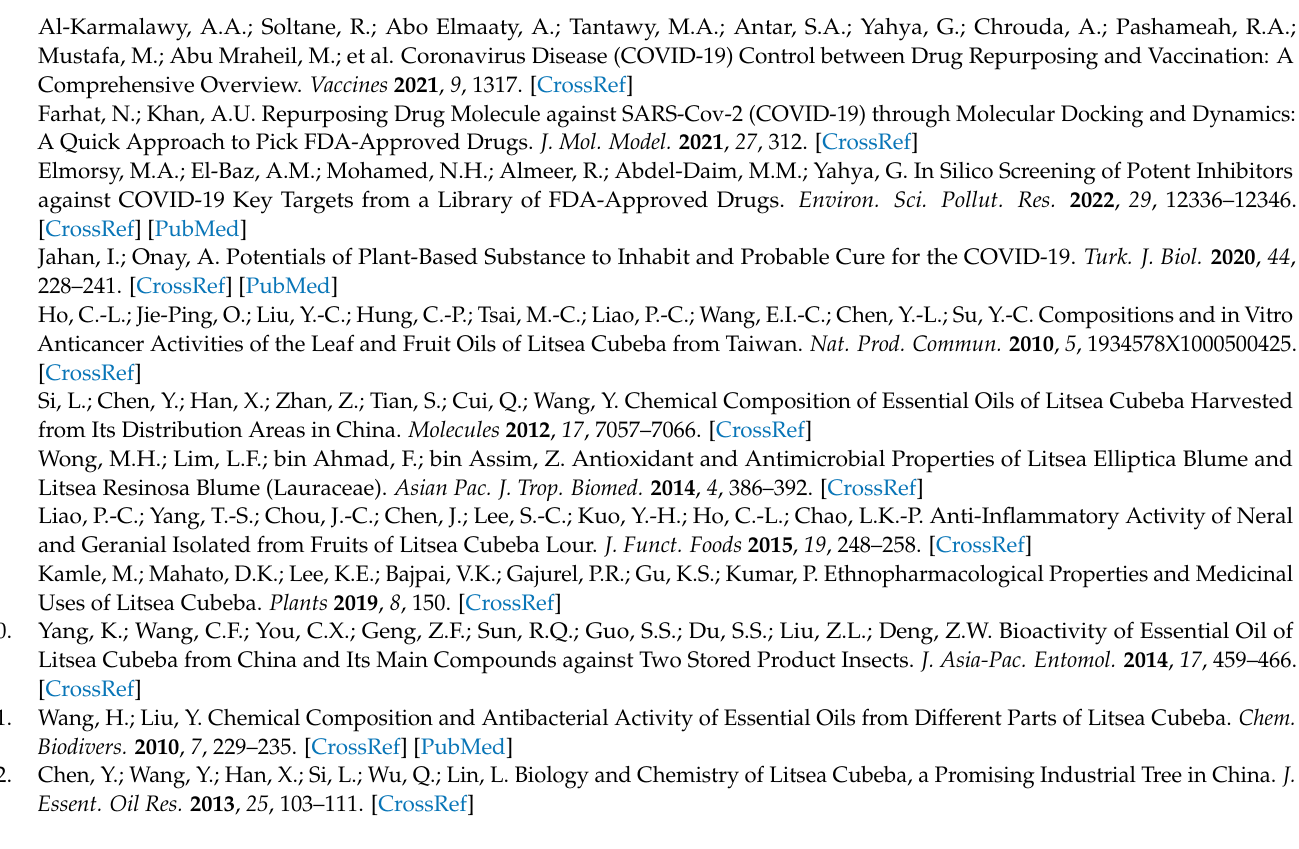
Mpro docked with reference compound GC376 extracted from 100 ns MD simulation. Figure S4. RMSF plots for SARS-CoV-2 M pro (a) Cassameridine, (b) Laetanine, (c) Litseferine, (d) Cassythicine, and (e) GC376- reference compound for the 100 ns MD simulation time. Figure S5. RMSF plots for docked complex and reference (a) Cassameridine, (b) Laetanine, (c) Litseferine, (d) Cassythicine, and (e) GC376 for the 100 ns MD simulation time. Figure S6. (a) Protein-ligand interactions mapping for SARS-CoV-2 docked with reference compound GC376 inhibitor. (b) Schematic representation for SARS-CoV-2- GC376 complex for the 100 ns MD simulation